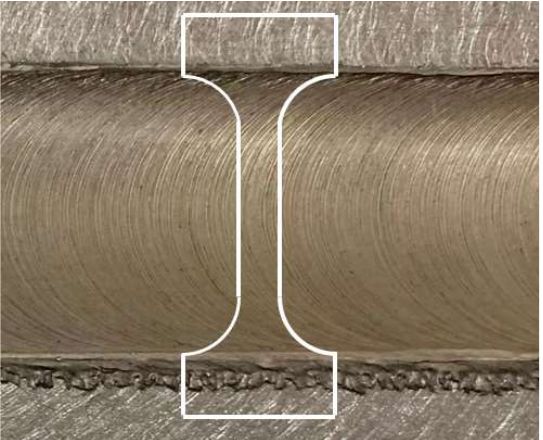
Figure 1. Locations and orientations of tensile testing specimens for high temperature deformation.